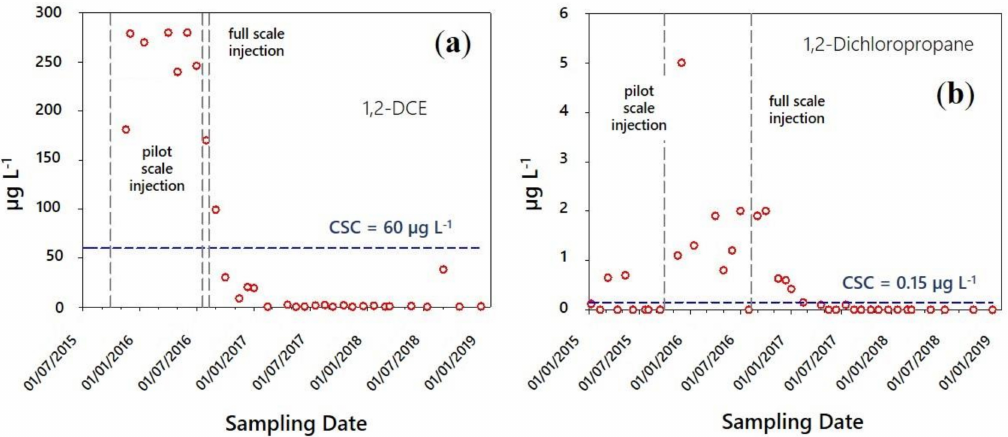
Figure 10. Concentrations of ( a ) 1,2 dichloroethene (1,2-DCE) and ( b ) 1,2-dichloropropane detected in a piezometer installed in the pilot test